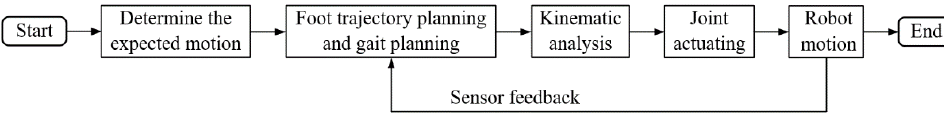
Figure 2. Main contents of the motion control algorithm.